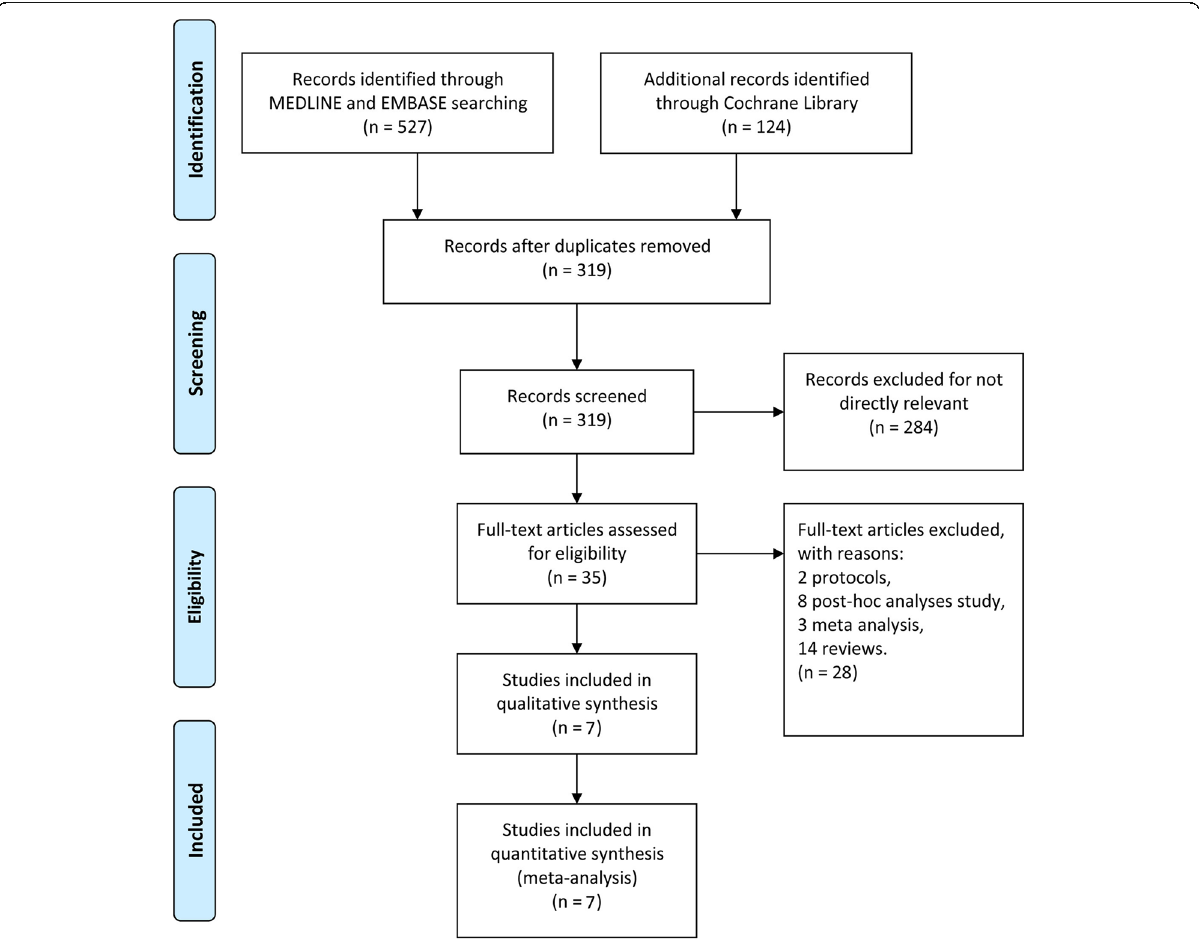
Fig. 1 The study search, selection, and inclusion